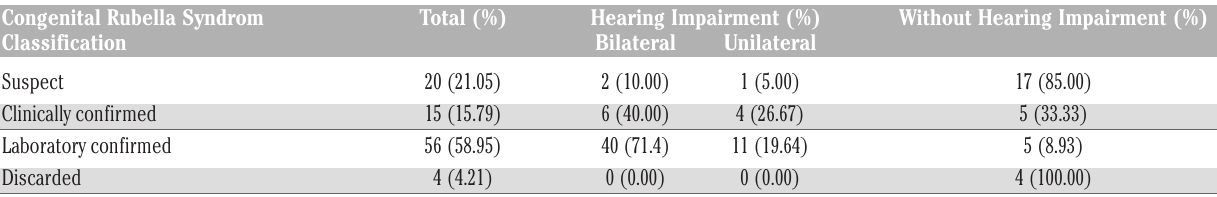
Table 3. Classification and Hearing Impairment in Congenital Rubella Syndrome.